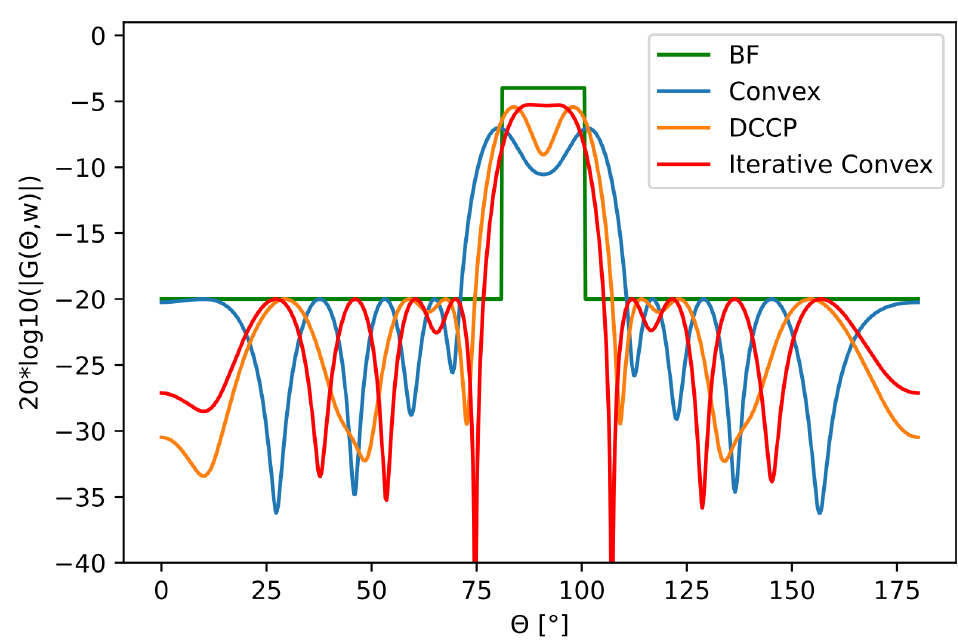
Figure 5. Uniform rectangular wide beampattern transmission mask in a 20 ◦ interval together with optimized beampatterns.